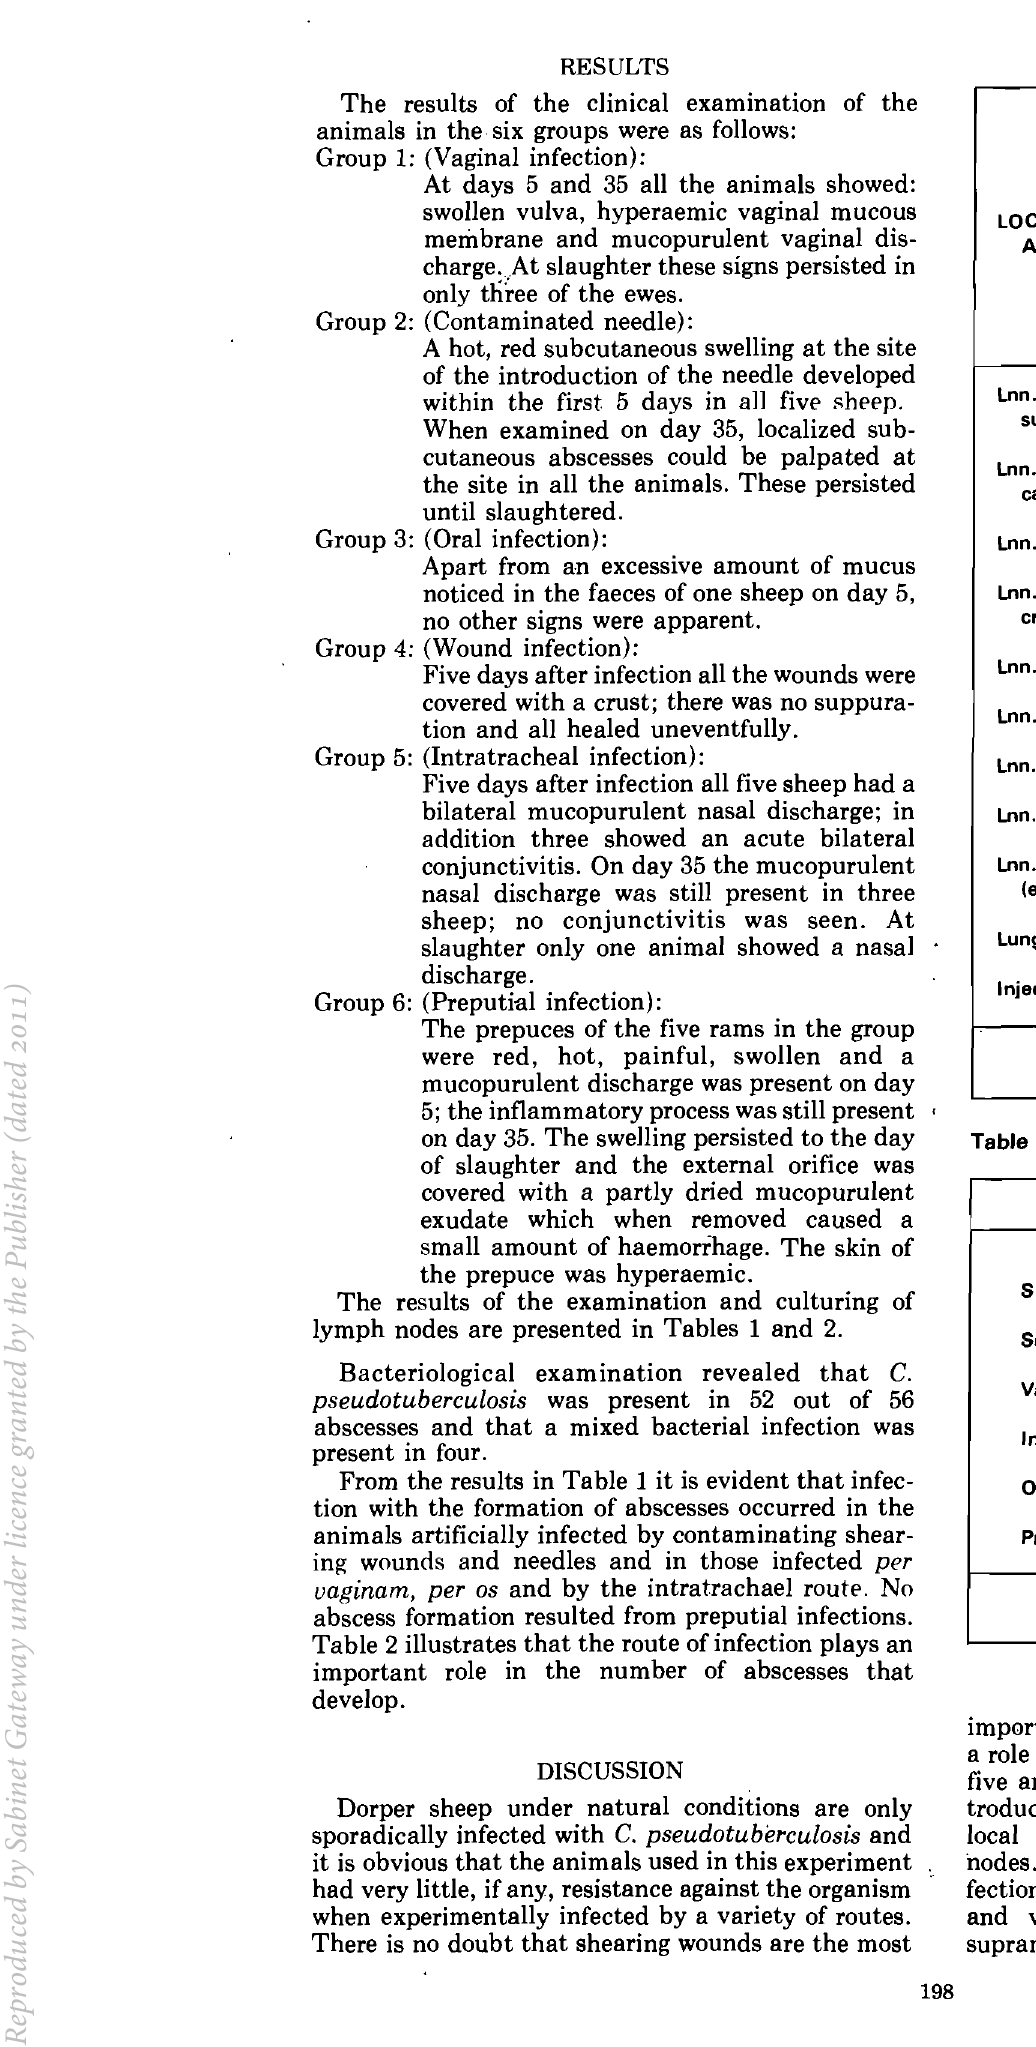
Table 1: INCIDENCE OF ABSCESSES